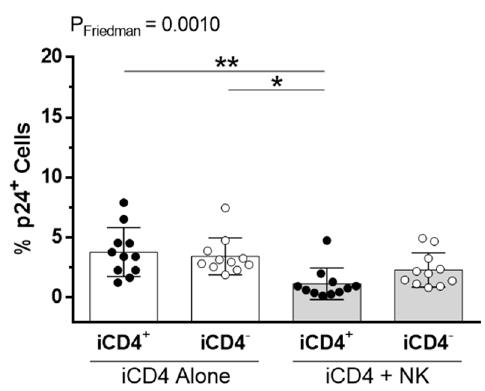
Figure 5. Natural killer (NK) cells preferentially target HIV-infected CD4 T cells that conserve cell-surface CD4 expression. The frequency of HIV-infected (p24 + ) cells within both iCD4 + and iCD4 − T cell subsets from iCD4 cultured alone (white bars) or co-cultured with NK cells (grey bars) for 10 days ( n = 11). Friedman (P Friedman ) and Dunn’s post (*) tests were used to determine significance of within subject differences between data sets. Each data point represents T cells isolated from a separate individual. Significant values are shown; * p < 0.05; ** p < 0.01.